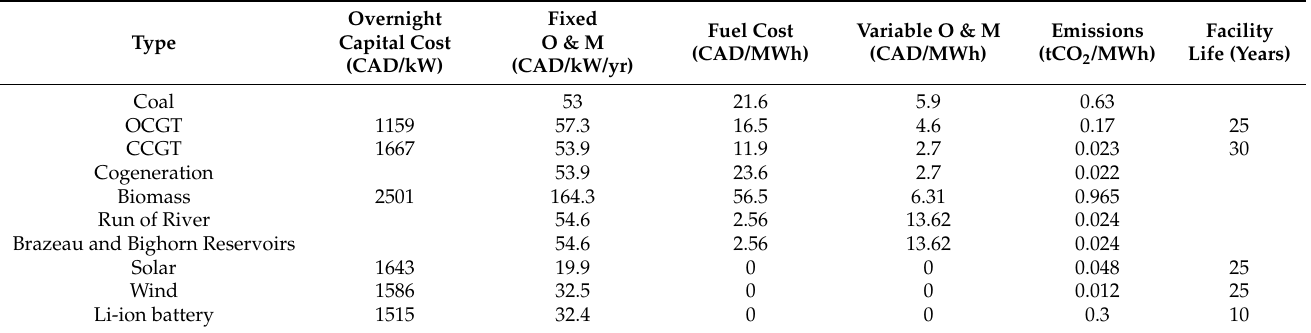
Table 2. Cost of Electricity Estimates for OCGT, CCGT, Solar, Wind and Battery Power (CAD 2019 per MWh) a